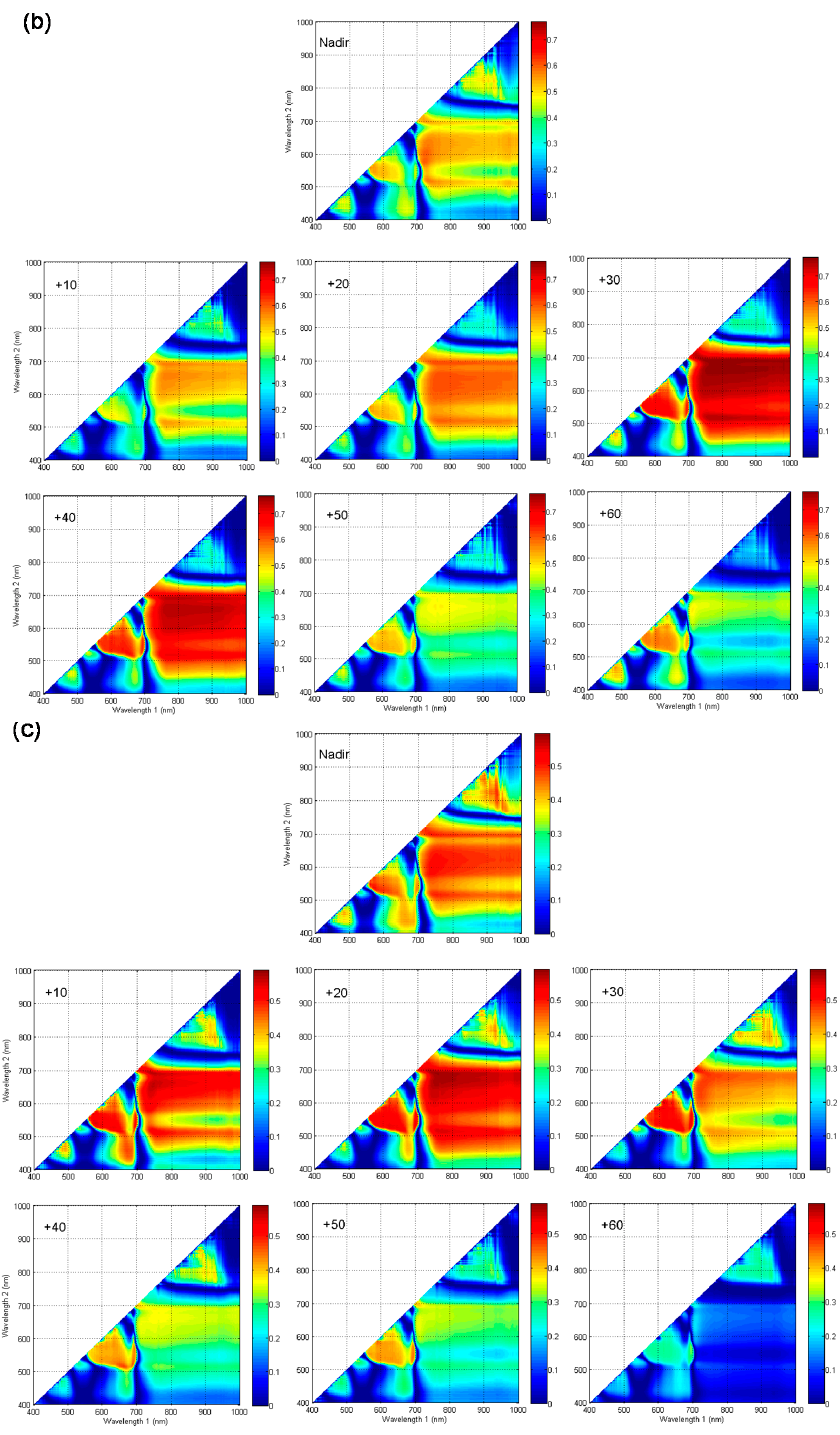
Figure 4. Contour maps of the coefficients of determination (R 2 ) for the relationships between NDVI-like ( λ 1, λ 2) indices ( λ 1 and λ 2 are wavelength 1 and wavelength 2 on the corresponding axes) calculated from all possible two-band combinations from 400 to 1000 nm and leaf Chl content in: ( a ) the upper-layer; ( b ) the middle-layer; and ( c ) the bottom-layer of wheat canopies at the nadir and six backscattering viewing angles, respectively.